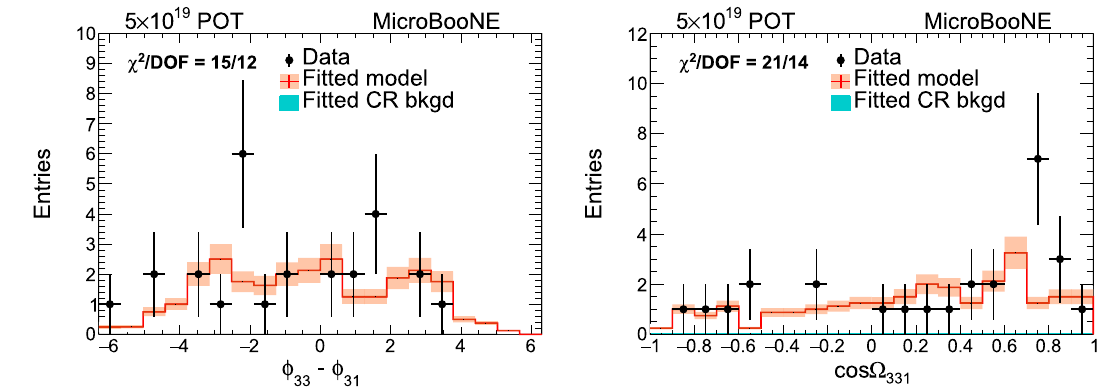
Fig. 26 Multiplicity = 3 φ 3 − φ 1 distribution (left); cos (cid:18) 31 distribution between first and third track (right) from neutrino-enriched sample for data and GENIE default MC